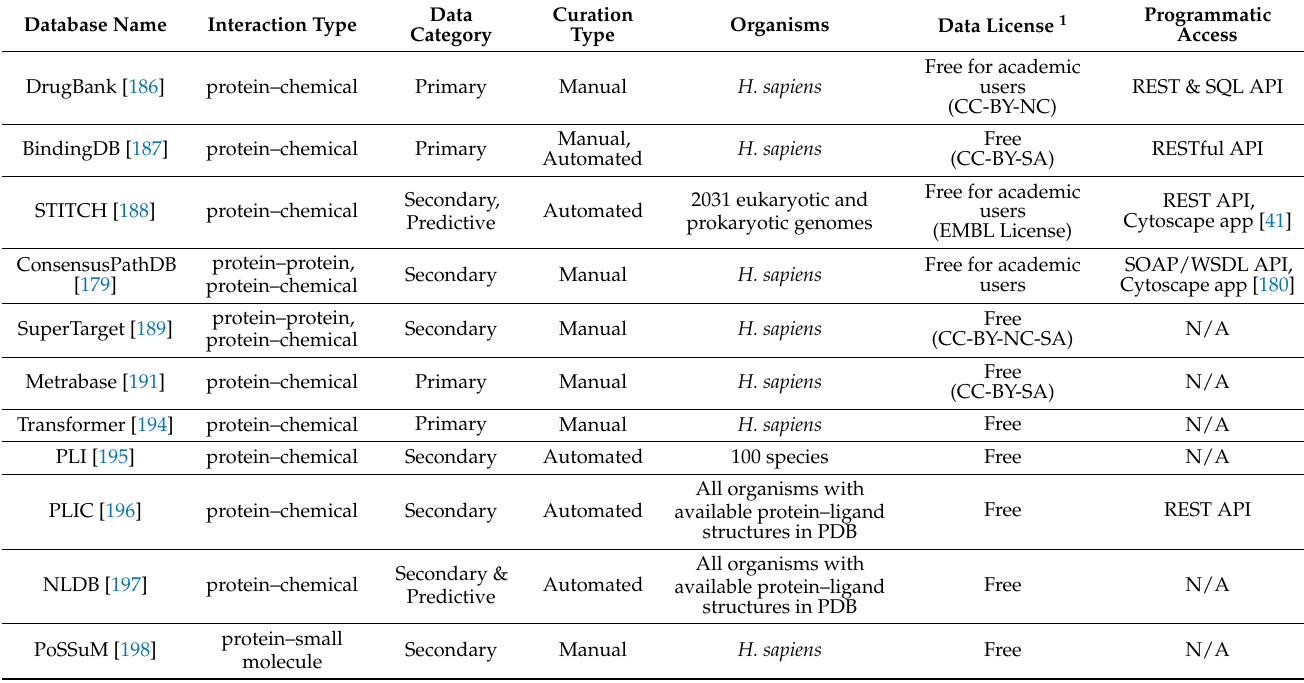
Table 6. Protein–small molecule interactions